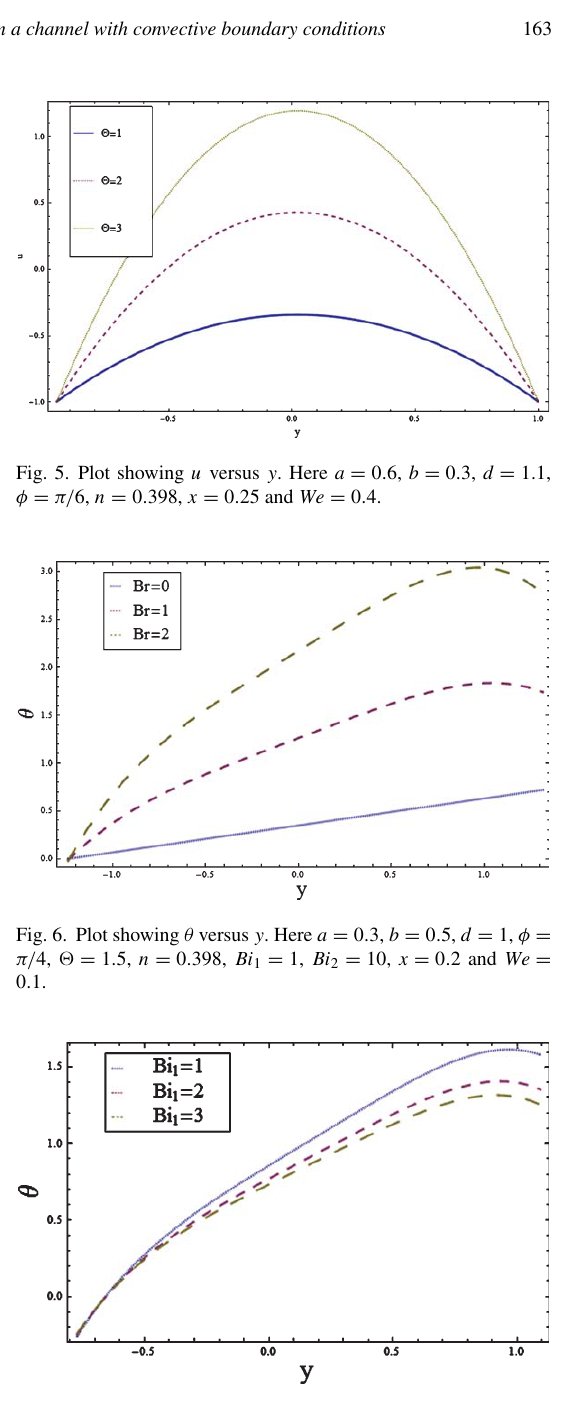
Fig. 7. Plot showing θ versus y . Here a = 0 . 3, b = 0 . 5, d = 1, φ = π/ 4, (cid:14) = 1 . 5, n = 0 . 398, Br = 1, Bi